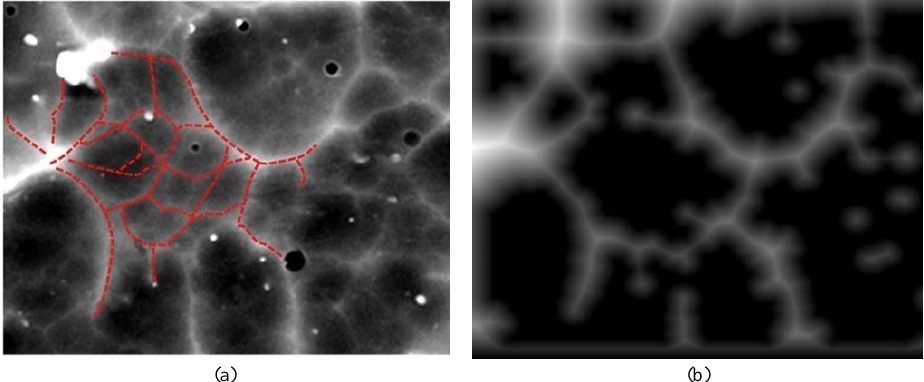
Figure 17. Comparison of the initial contour (a) and the contour that was obtained using the inverse Fourier transform (b)